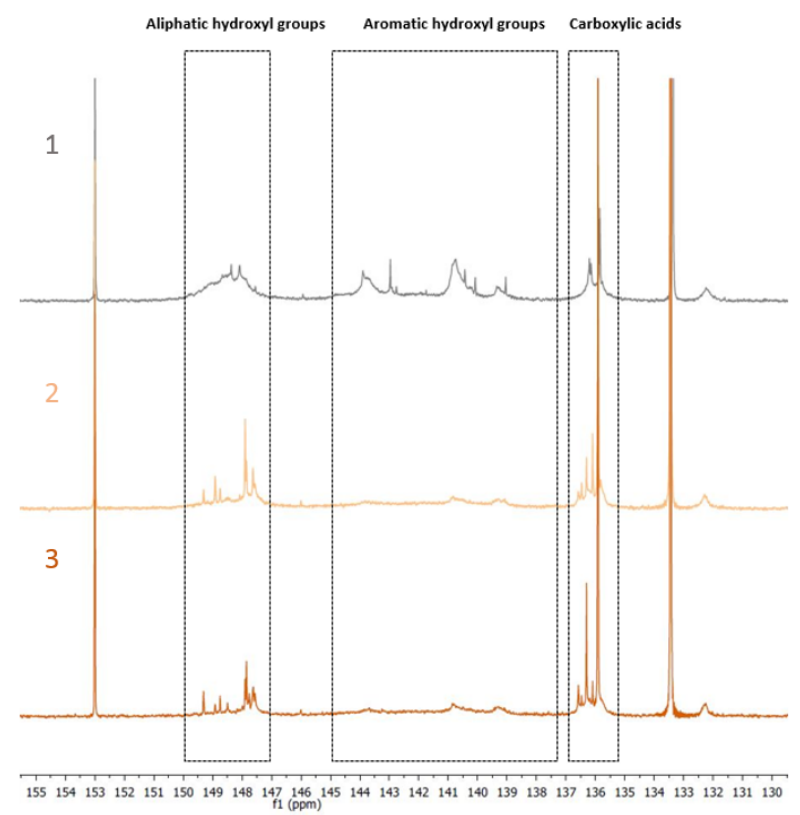
Figure 6. 31 P NMR spectra of Protobind 1000 (spectrum 1 in gray), BSG U Lignin (spectrum 2 pale orange), BSG T Lignin (spectrum 3 dark orange). Table 7. Detailed hydroxyl/carboxyl quantification by 31 P NMR (as mmol of functional group per g of dry